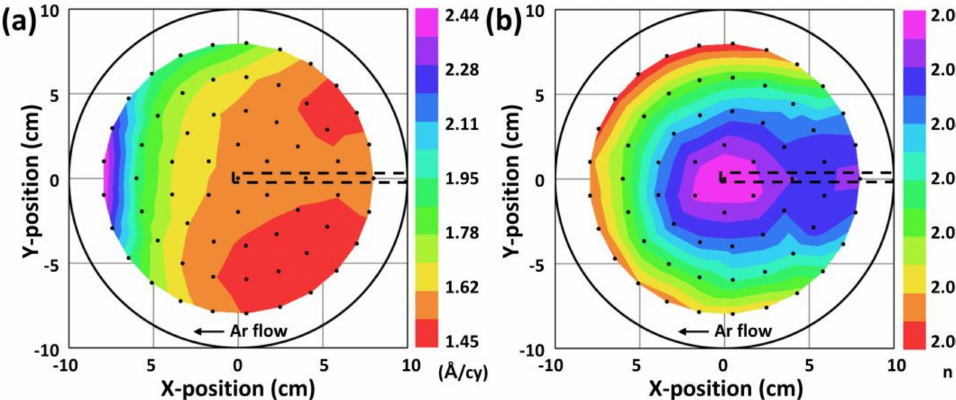
Figure 5. Uniformity of ( a ) GPC and ( b ) refractive index at the 8” wafer-scale measured by SE. The dots represent the locations at which SE data were